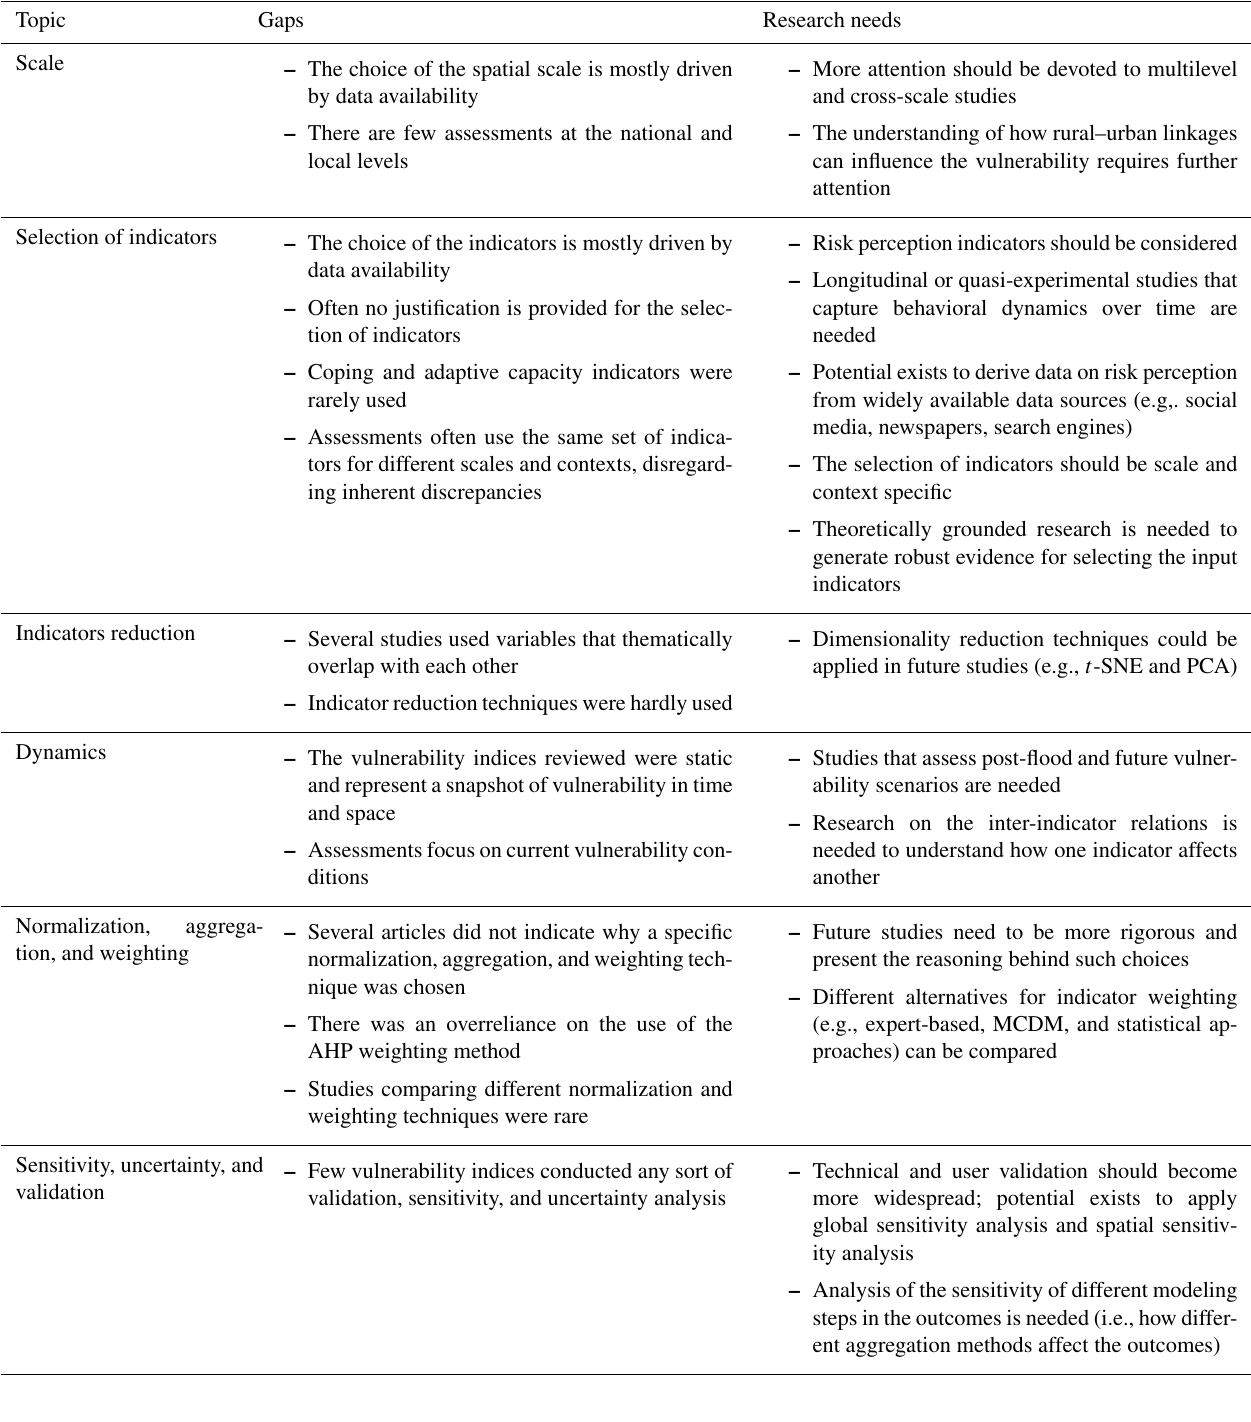
Table 7. Summary of the identified knowledge gaps and need for building flood vulnerability